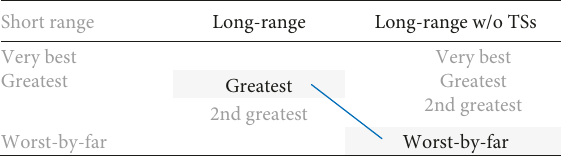
Table 14: Tabular representation of Rule 5.